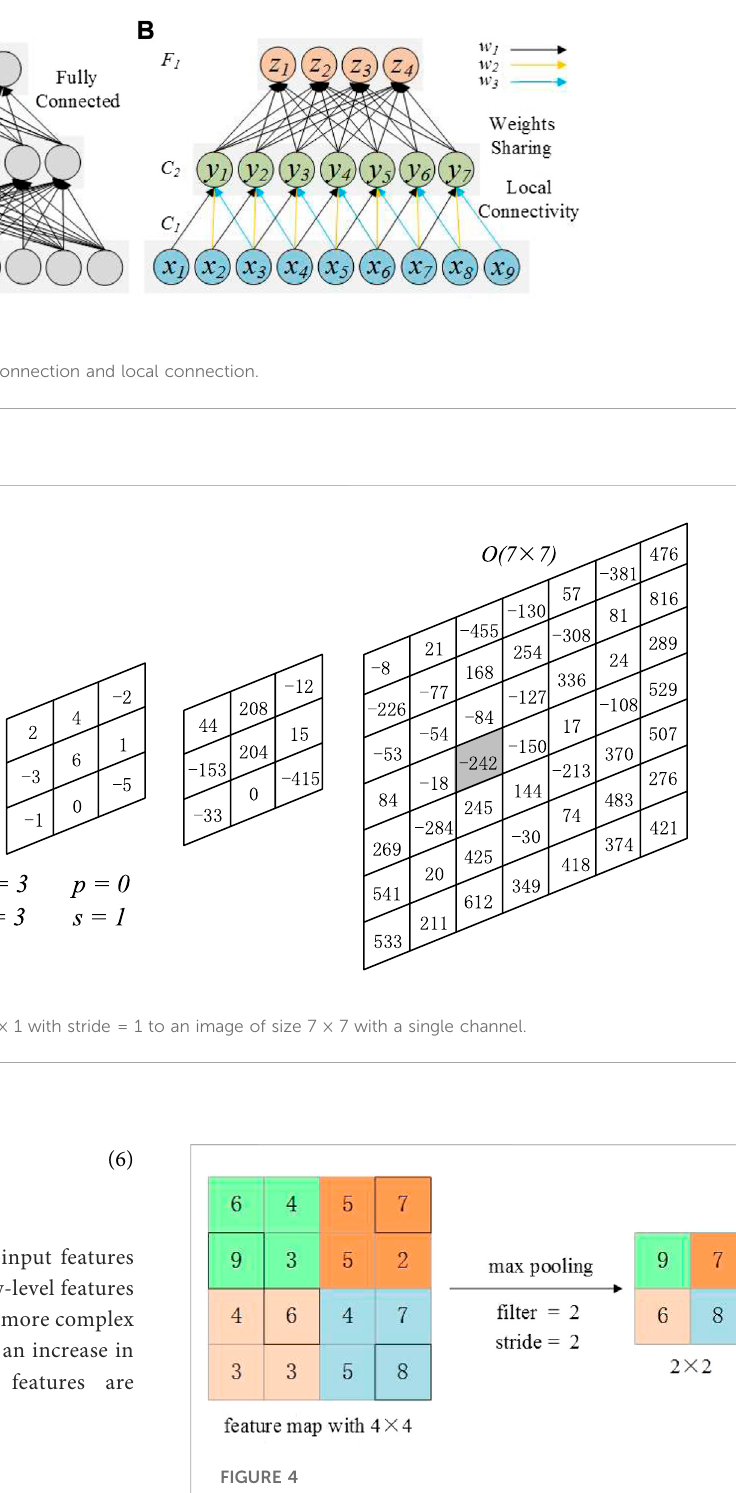
FIGURE 4 2 × 2 max pooling applied to a feature map of size 4 × 4 with stride